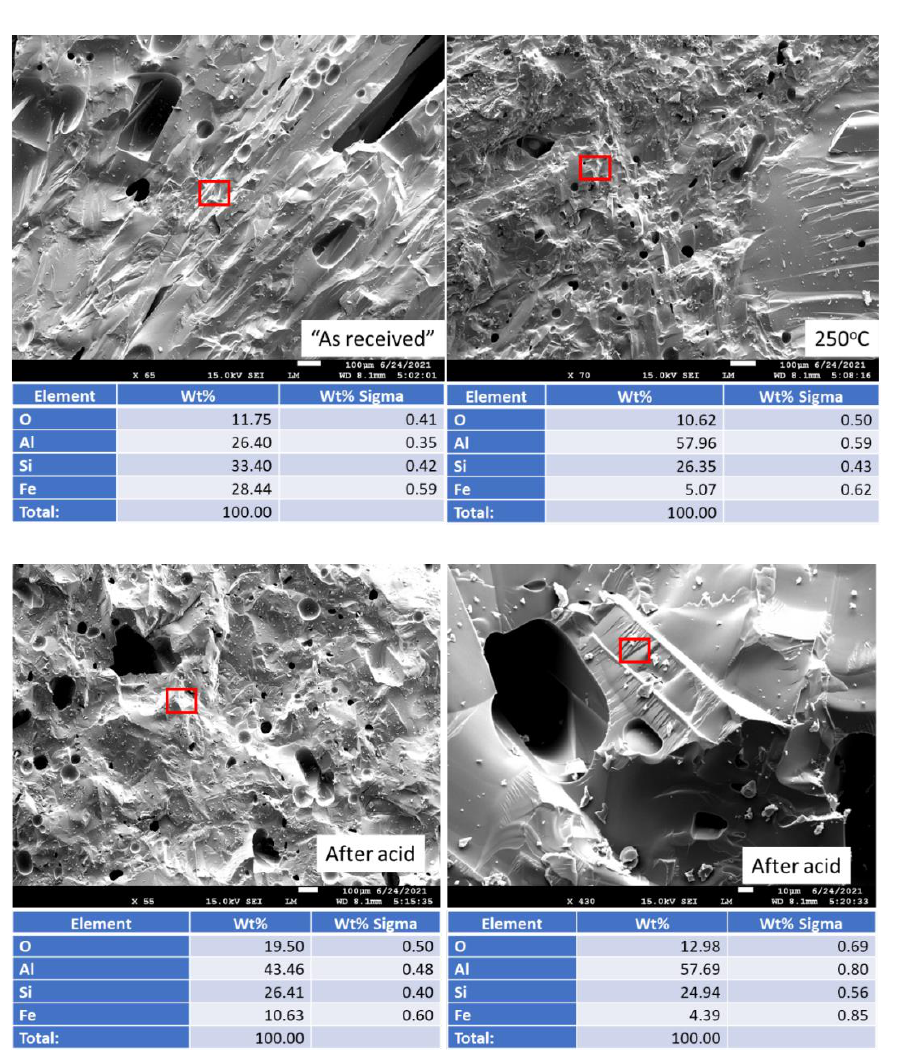
Figure 18. Photomicrographs of mullite samples with the elemental composition of typical sites shown by the red boxes.